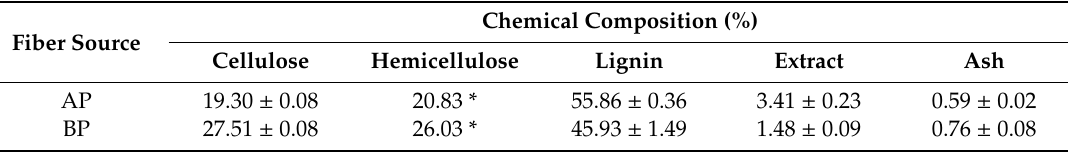
Table 1. Chemical composition of the of Leopoldinia piassaba (AP) and Attalea funifera Martius (BP). Chemical Composition Fiber Source